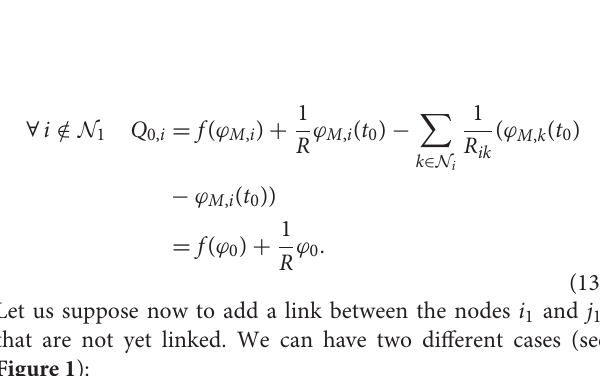
FIGURE 1 | Network of N coupled MOCs. (A) For simplicity, we suppose a sphere of influence of radius one and zero boundary conditions. The memristor initial state of the first MOC is different with respect of the other ones. When we add a link between node i 1 and node j 1 6= 1, we have two possibilities: either (B) i 1 6= 1 or (C) i 1 =